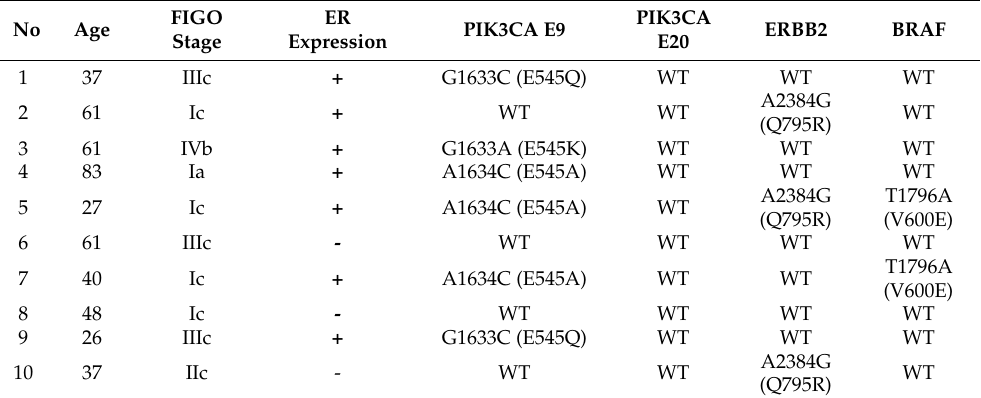
Table 1. Expression status of ER and oncogenic mutation in LGSOCs.